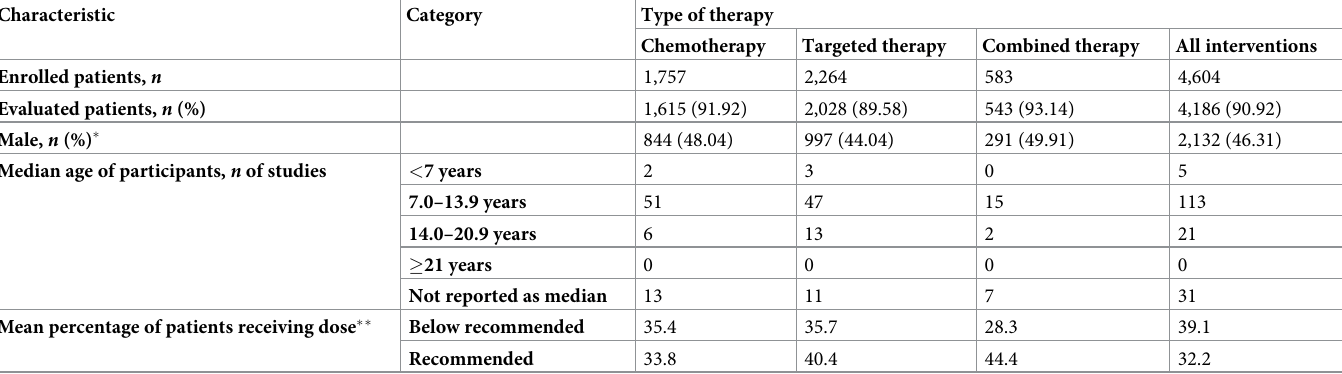
(cid:3) Gender was not reported in 12 chemotherapy, 17 targeted therapy, and 4 combination therapy studies. (cid:3)(cid:3) Calculated as a mean of percentage of patients given recommended dose or dose below recommended dose in individual studies, weighted by the size of the study (if such data were